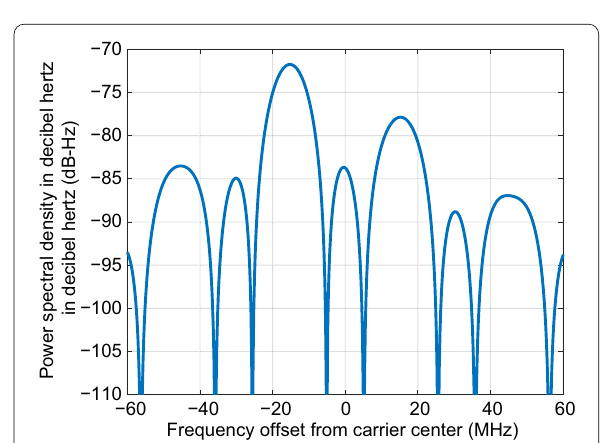
Fig. 2 Multiplexing modulation power spectral density of Type-II ACE-BOC